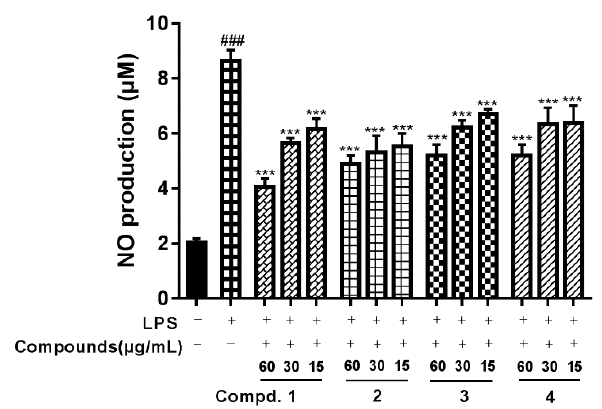
Figure 3. Effect of compounds 1 – 4 on NO production in LPS-stimulated macrophages. Macrophages were stimulated with LPS (100 ng/mL) for 24 hours in the absence or presence of compounds 1 – 4 (15, 30 or 60 μg/mL). The production of NO was assayed in the culture media. Each value represents the mean ± standard error of the mean (SEM) ( ### p ＜ 0.001 versus with control group; *** p ＜ 0.001 versus with LPS).